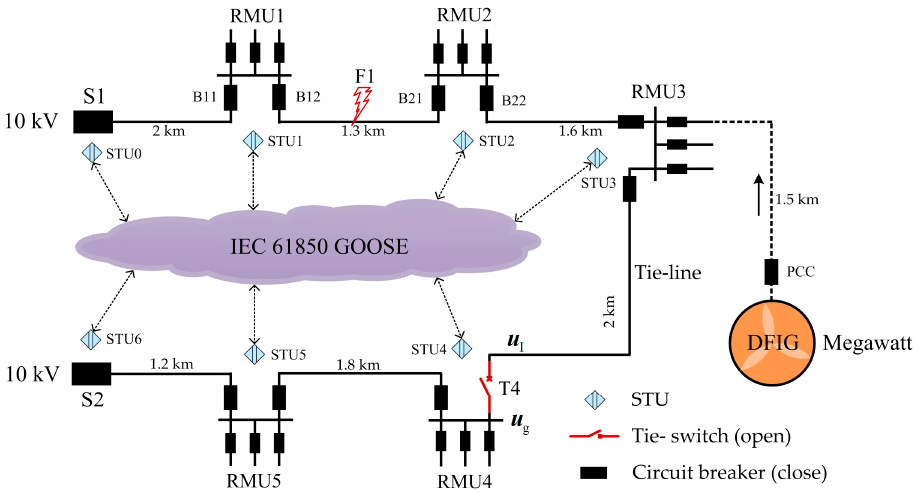
Figure 1. Distribution system under study.